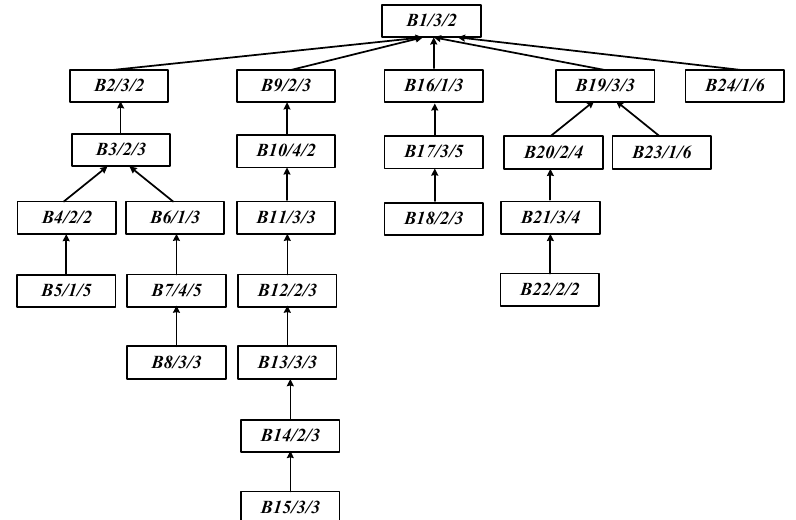
Figure 8. The processing operation tree of complex product B .